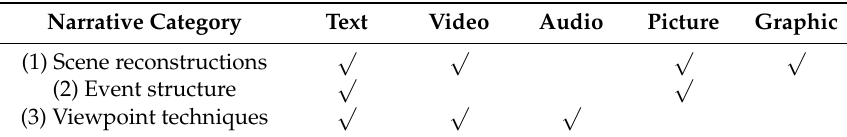
Table 2. Expression of narrative techniques in the media formats employed in Snow Fall